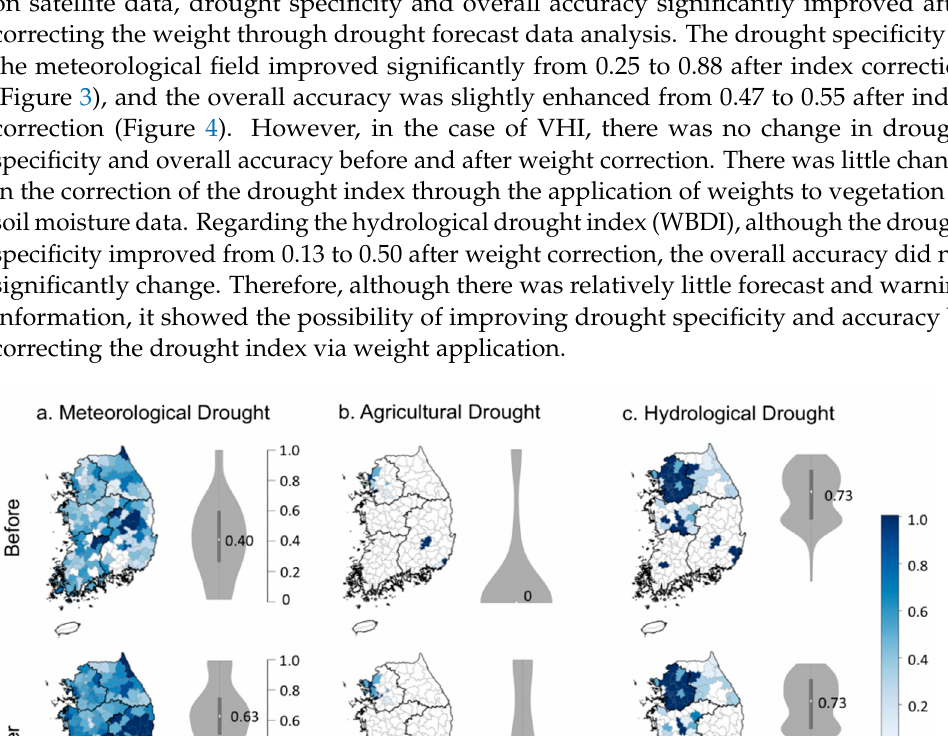
Figure 4. Accuracy distribution of the ground data-based drought index. 3.2. Results of Correlation Analysis with an Integrated Drought Index In the development of the integrated drought index, values of the integrated drought index were calculated by applying the meteorological drought index SPI, agricultural drought index SRSI, and hydrological drought indices SRSI and SDI, calculated based on ground data, to the dimension reduction model through linear and nonlinear models. For 167 administrative district-based basins, an integrated drought index was developed by applying a Bayesian PCA (BPCA)-based combination model that explains the variation of 66.8% on average (67.3% after index correction) for the four drought indices (SPI, SRI, SRSI, and SDI). The integrated drought index showed a relatively high correlation with SRI (median value: 0.87), a correlation of 0.79 with the meteorological drought index SPI, and a correlation of 0.75 with the hydrological drought indices SRI and SDI (Figures 5 and 6). In this study, the BPCA method was applied to the basin when all three drought indices were provided for 167 municipalities, and the LSCORE method, showing a relatively high correlation, was applied to basins when only two drought indices were provided.